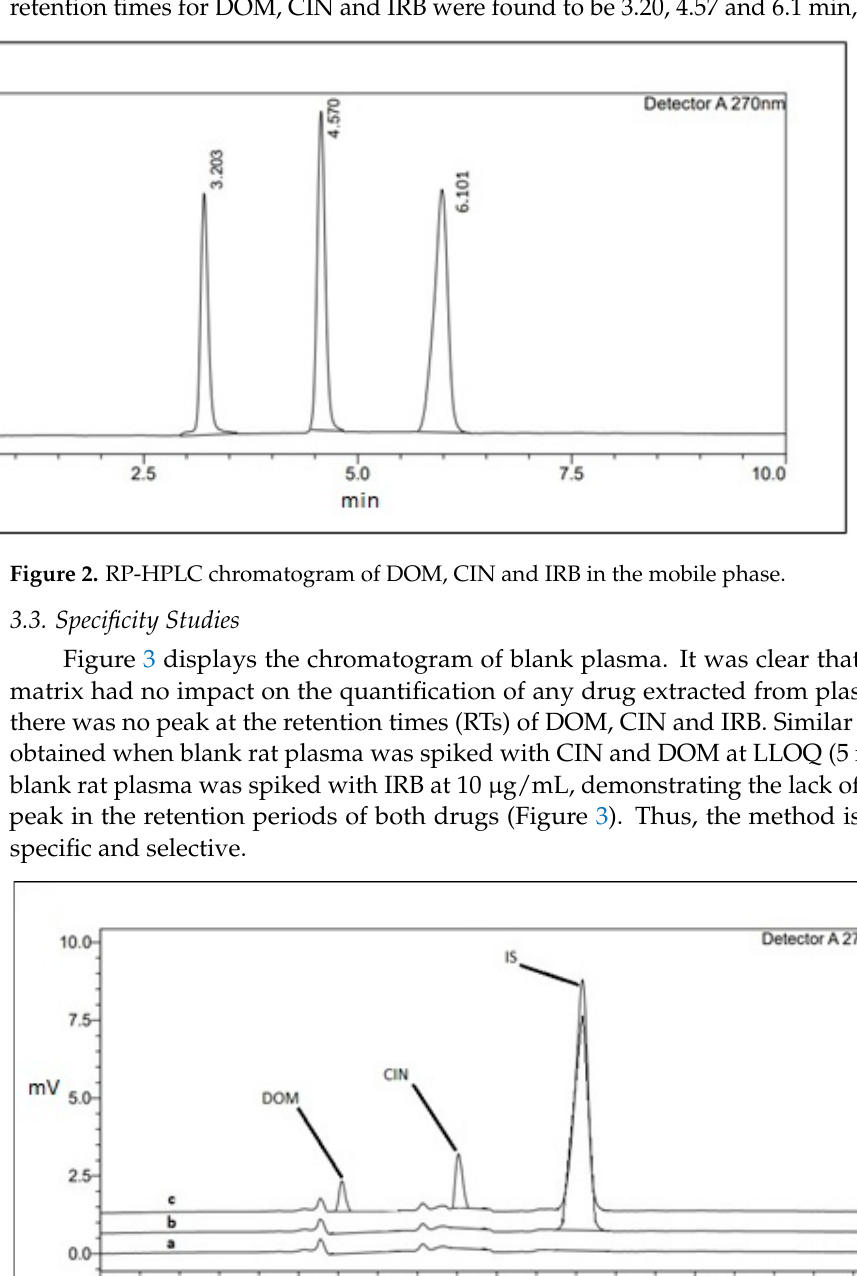
Figure 1. Reverse-phase high-performance liquid chromatography (RP-HPLC) chromatogram of DOM and CIN in plasma at LLOQ concentration with IRB as internal standard.